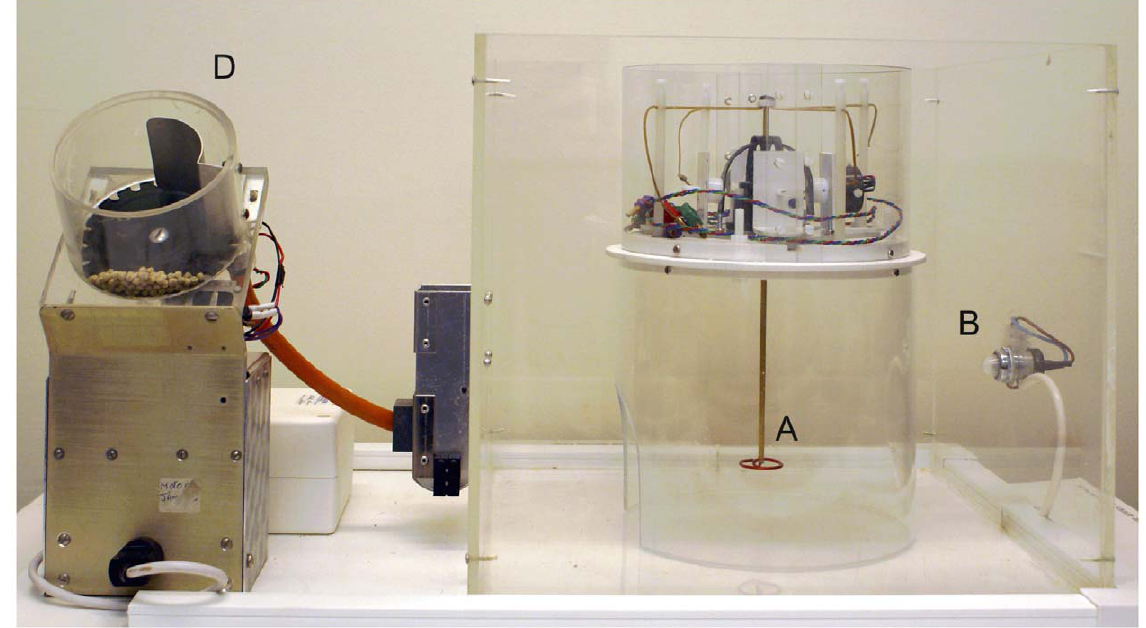
Figure 2. Experimental set-up for rats, showing (A) manipulandum, (B) location of visual signal of reinforcement, and (D) food hooper for delivery of rewards to maintain behaviour (not present for human subject).